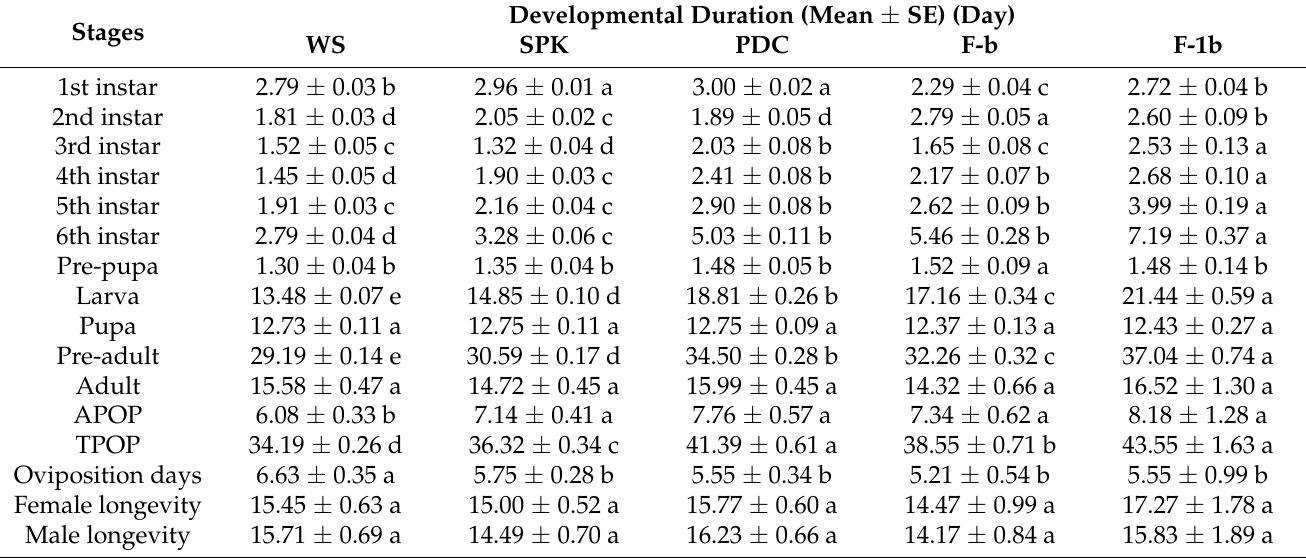
Table 1. Developmental duration of the FAW fed on different wheat tissues in the